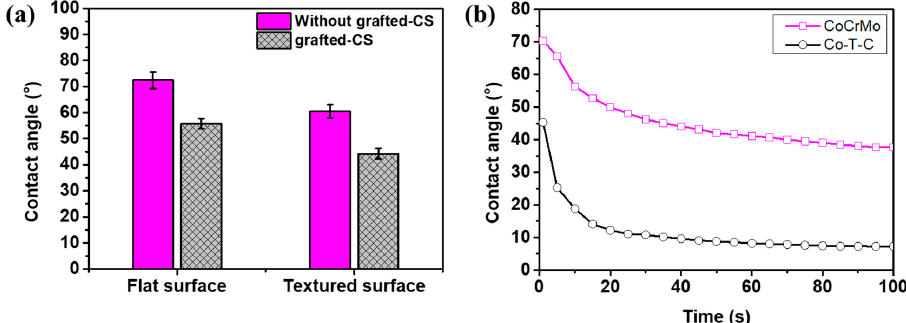
Figure 5. Contact angle in aqueous solution: ( a ) static contact angles and ( b ) the evolution with time increased.